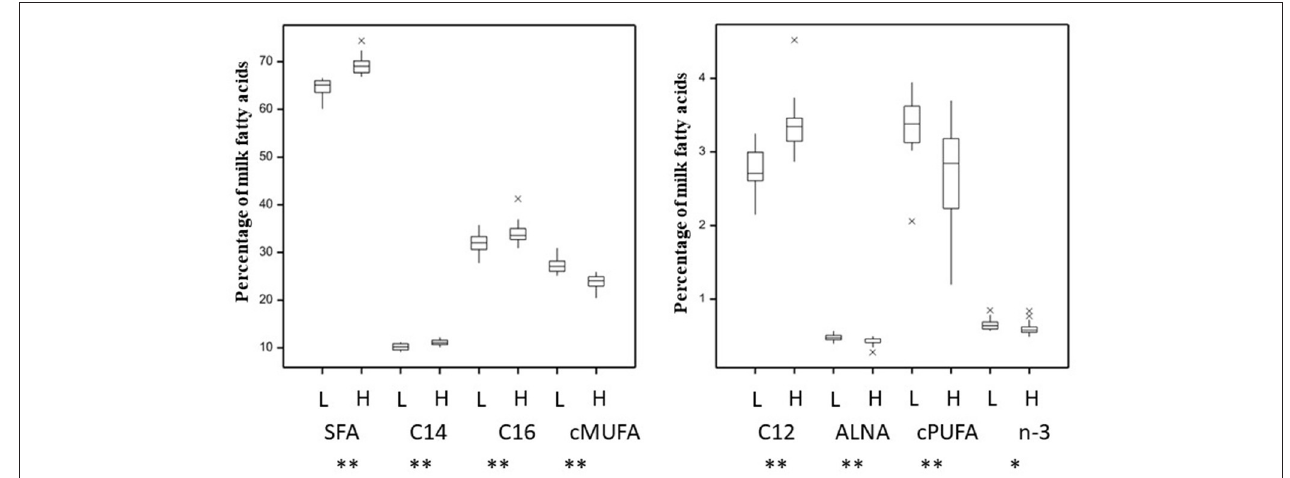
FIGURE 1 | Variation in milk saturated (SFA, C12, C14, C16) and unsaturated ( cis- MUFA, cis- PUFA, ALNA, and n- 3) fatty acids (as a percentage of total fatty acids) for 48 animals grouped between Low-(L) and High-(H) milk SFA. * P < 0.05, ** P < 0.01.